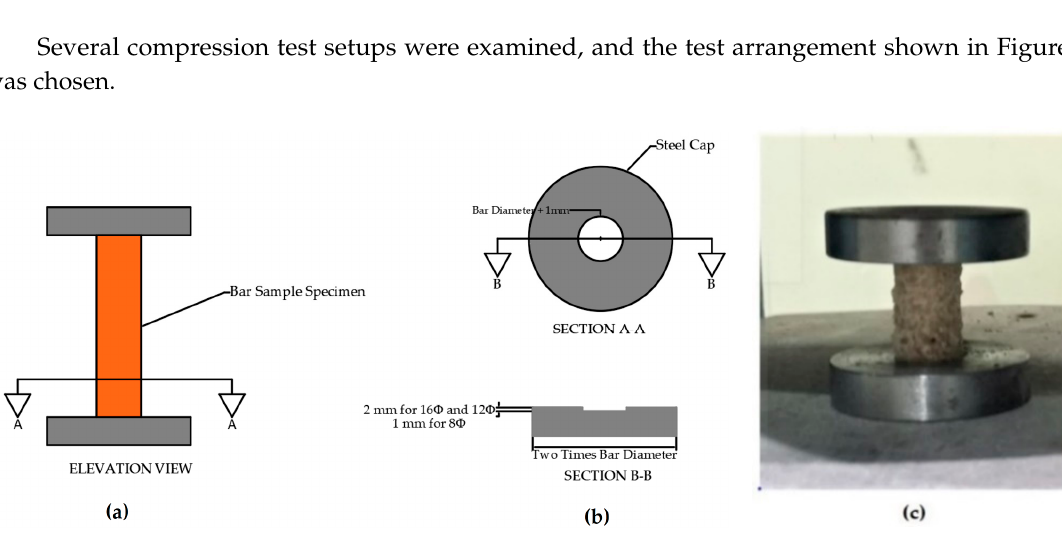
Figure 2. ( a ) Schematic drawing of the apparatus used for the compression tests of the GFRP and BFRP bars: ( b ) cross sections; ( c ) actual compression testing apparatus .